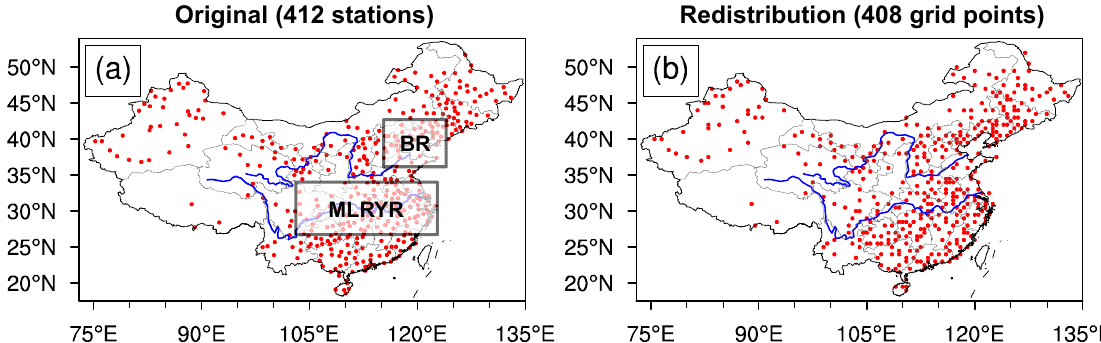
Figure 1. Locations of the homogenized 412 meteorological stations ( a ) and 408 station-redistributed grid boxes ( b ) over China. Note that BR and MLRYR in ( a ) means Bohai Rim area (115–124° E; 36–43° N) and the middle and low reaches of the Yangtze River (102.5–123° E; 26.5–34.5° N), respectively. The two blue curves in the figure represent the Yellow River (north) and the Yangtze River (south), respectively.